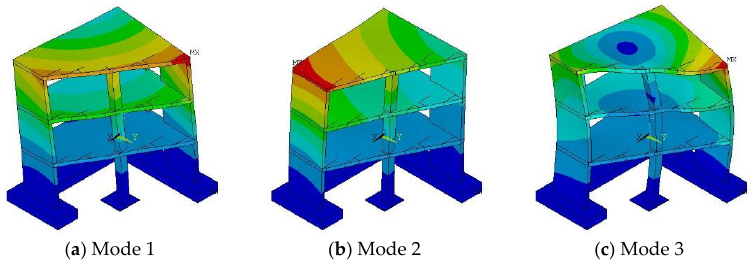
Figure 16. Mode shapes of the SMART 2013 RC structure for the model Case 2. Appl. Sci. 2018 , 8 , x FOR PEER REVIEW